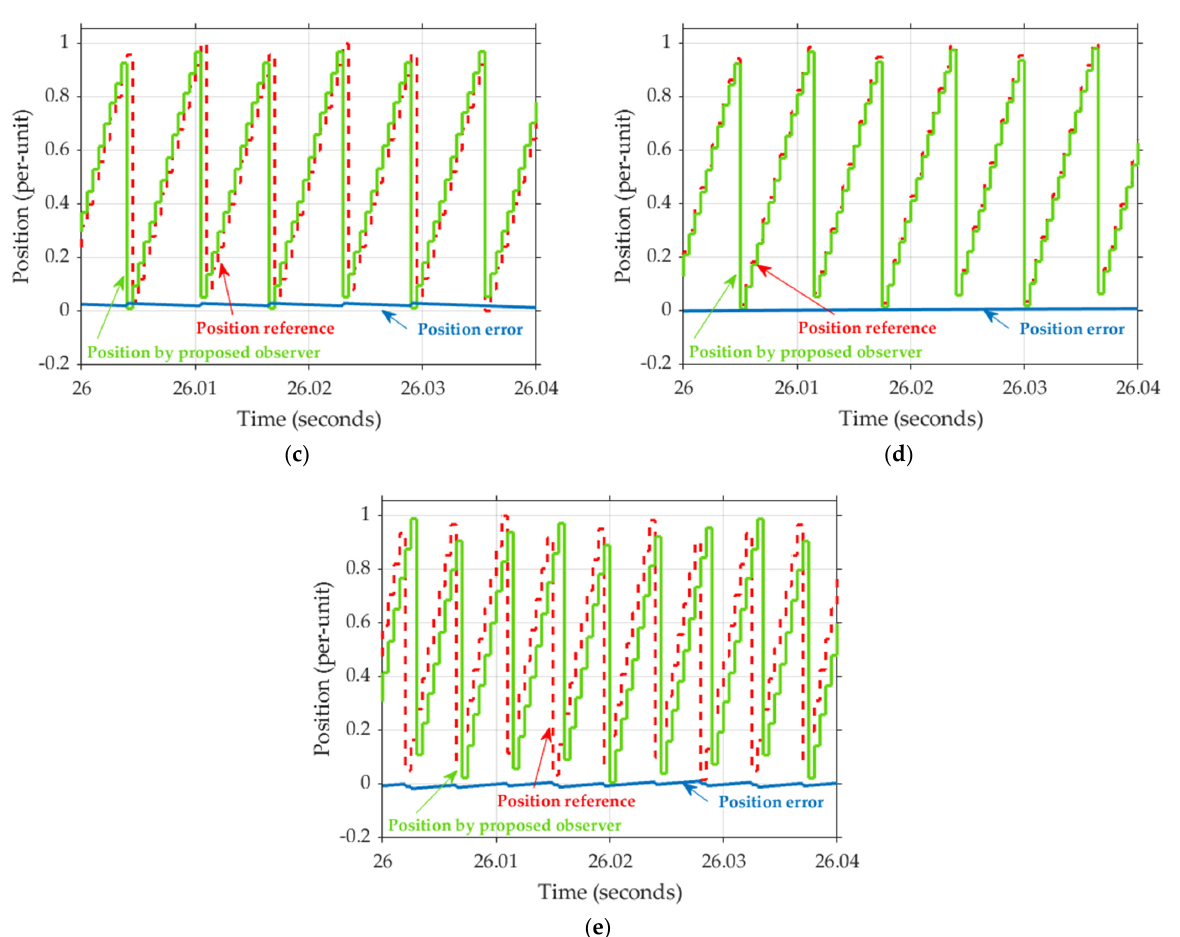
Figure 12. Simulation results for the rotor positions ( a ) PMSM 1; ( b ) PMSM 2; ( c ) PMSM 3; ( d ) PMSM 4; and ( e ) PMSM 5.